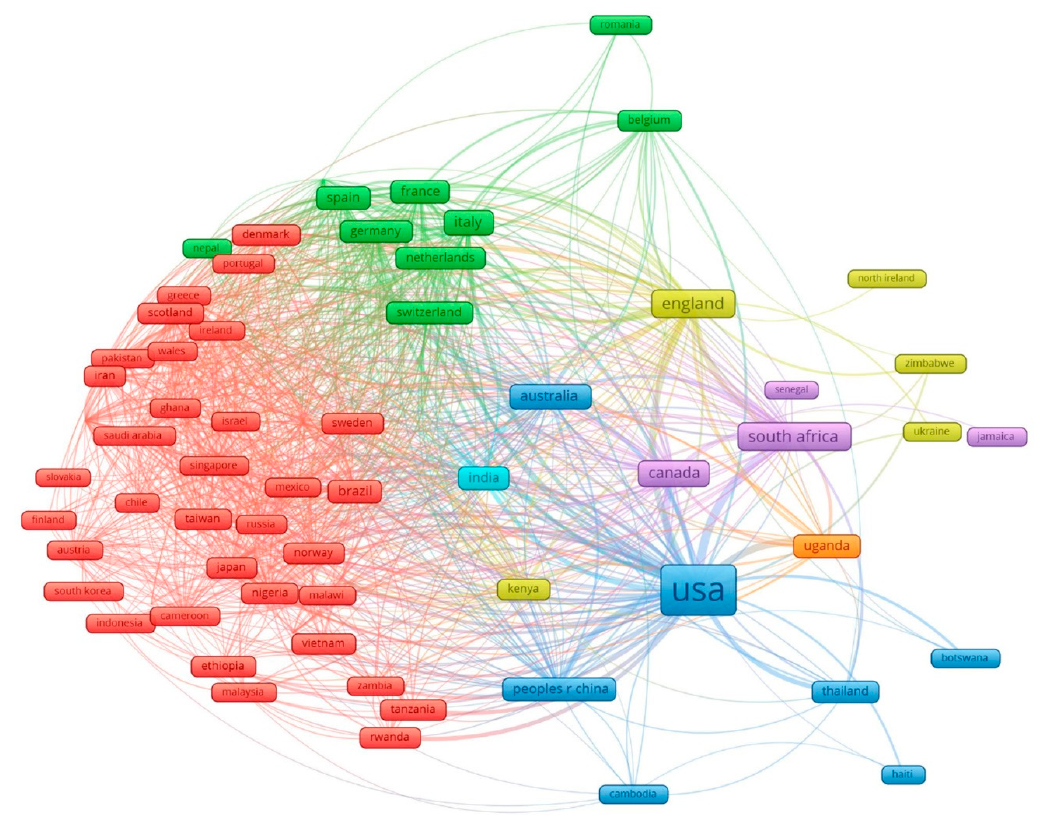
Figure 2. The global network among 68 countries having co-authorships of selected papers. The size of nodes shows the proportional contribution to the number of papers and the thickness of lines indicates the percentage of the number of collaborations.